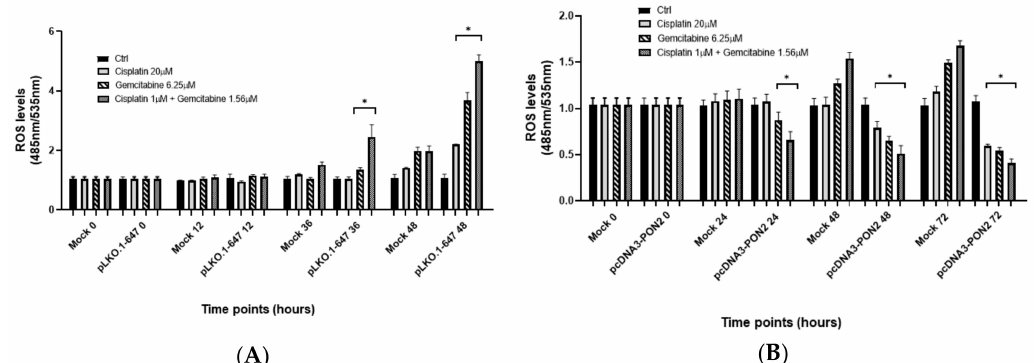
Figure 5. Intracellular Reactive Oxygen Species (ROS) levels in T24 cells upon treatment with drugs. In vitro e ff ect of PON2 silencing (panel A ) and overexpression (panel B ) on intracellular ROS production upon treatment with cisplatin (20 µ M), gemcitabine (6.25 µ M), or both compounds (cisplatin 1 µ M + gemcitabine 1.56 µ M). ROS levels were determined at di ff erent time points (0, 12, 24, 36, 48, and 72 h). All values are expressed as the mean ± standard deviation (* p <